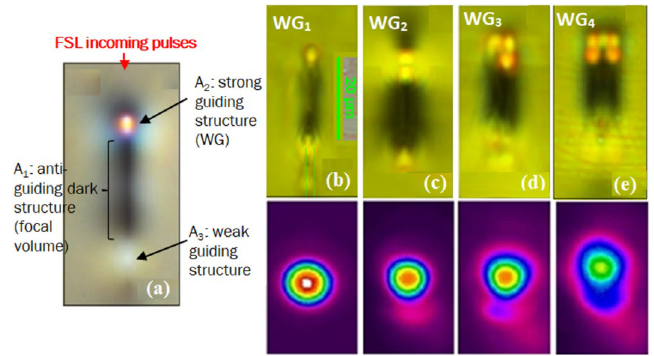
Figure 4. ( a ) 50 × bright field microscopy image illustrating the structural features of the single line FSL modified region (100 kHz PRF, 200 nJ pulse energy). The dark structure A 1 is the focal volume. A 2 above A 1 is the WG due to its strong guiding capability. A 3 below A 1 is a weaker guiding structure. The red arrow indicates the direction of the FSL incoming pulses. ( b – e ) are 50 × brightfield microscopy images of the modified regions (cross-sectional view in top row). ( b ) single line ( c ) double line (2 single lines inscribed 5 μm apart). ( d ) triple line (3 single lines 5 μm apart) ( e ) 2 × 2 array of single lines written 5 μm apart. The 2nd row represents the corresponding 1550 nm beam profiles of the WGs in the strong guiding